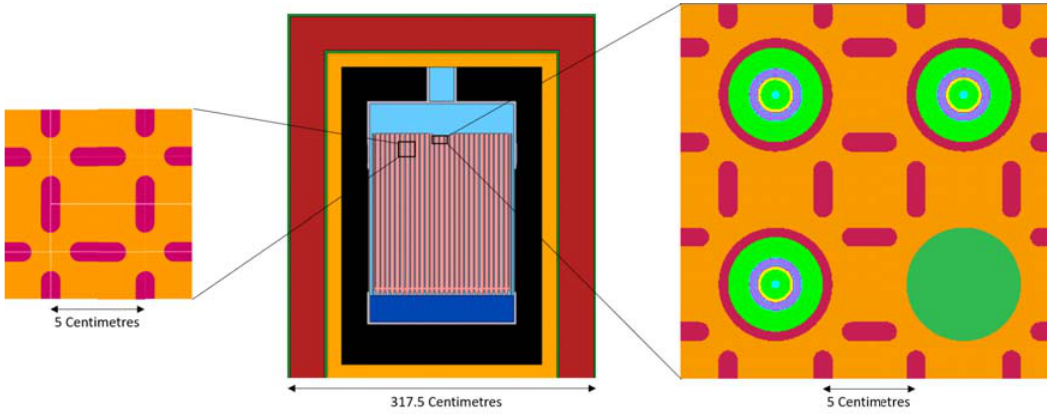
Figure 4: Examples of complex geometries passed to